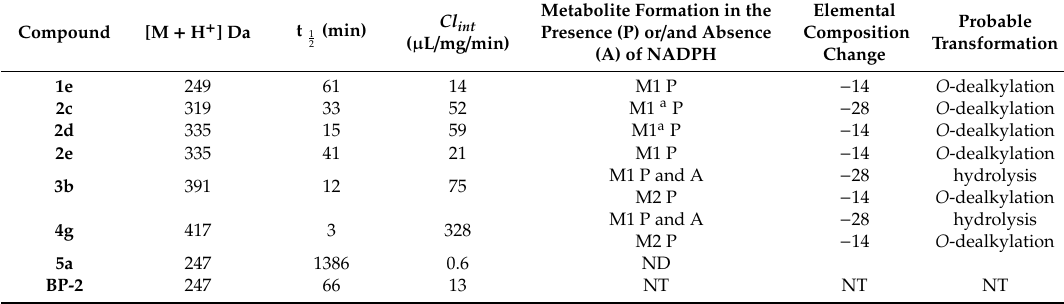
Table 4. In vitro stability (t 1 / 2 and Cl int ) of compounds 1e, 2c – 2e, 3b, 4g, 5a and reference